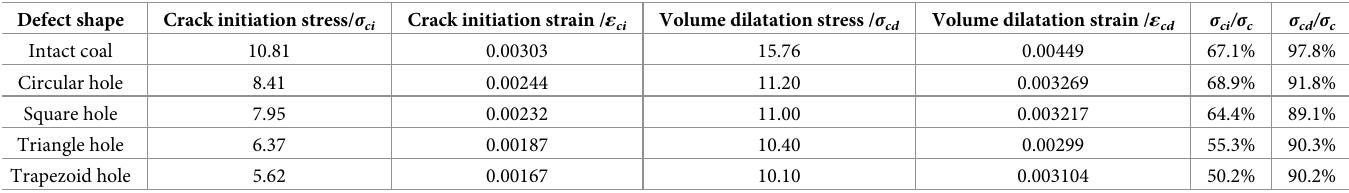
Table 4. Crack initiation stress and dilatation stress values of coal and